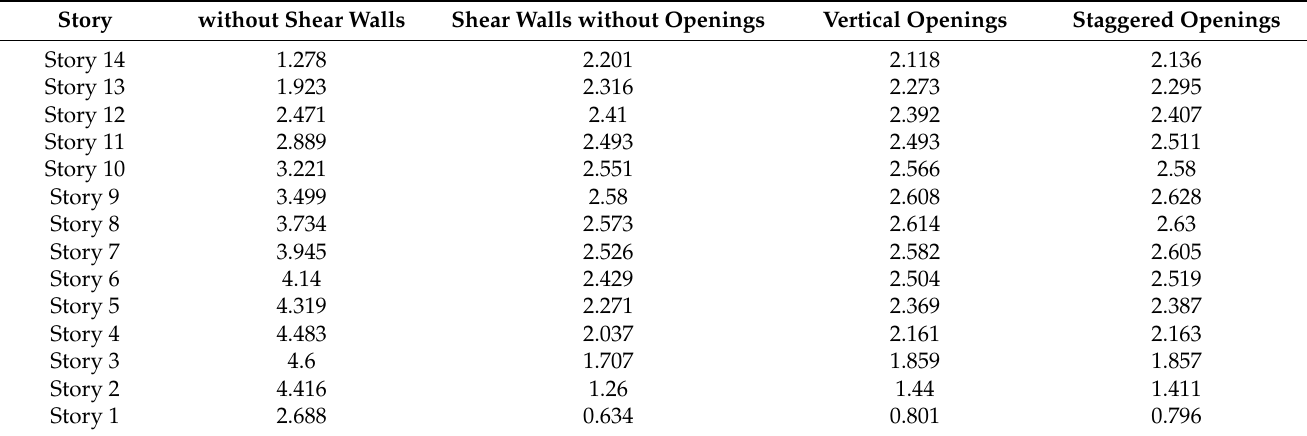
Table 13. Comparison of the story drift, response spectrum analysis, and Y-direction